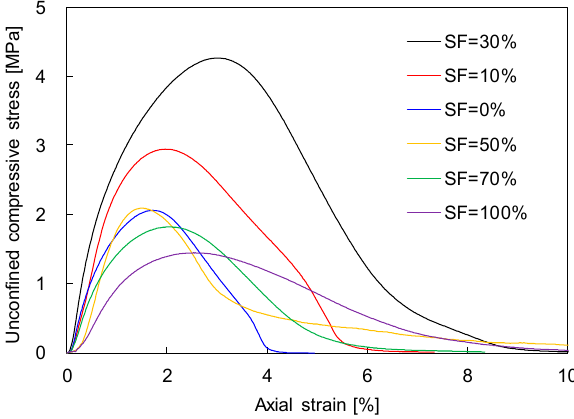
Figure 10. Typical unconfined compressive stress-strain curve with different SFs subjected to N = 100.